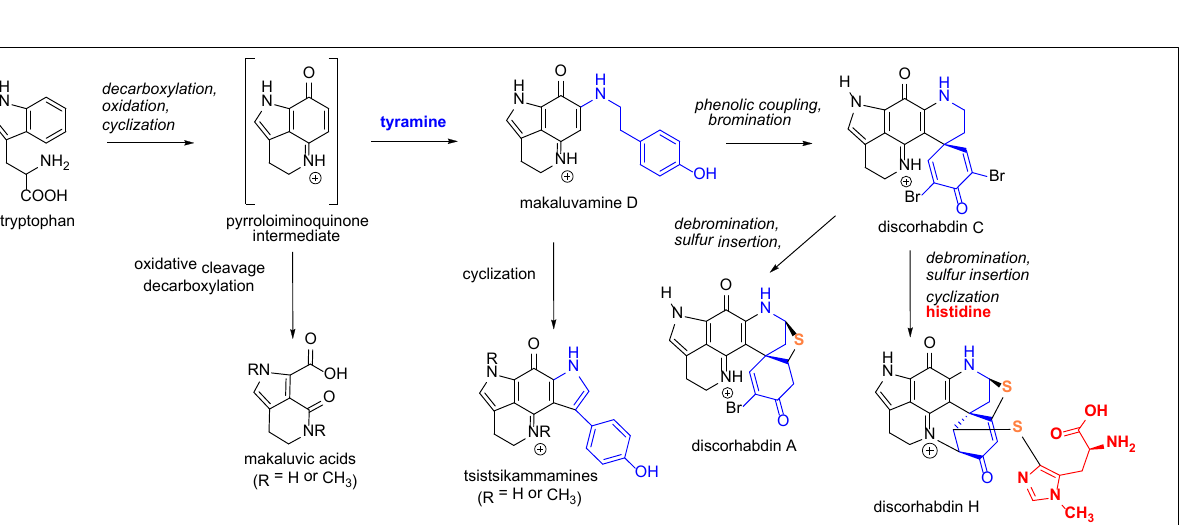
Scheme 1: Proposed biosynthesis of pyrroloiminoquinone